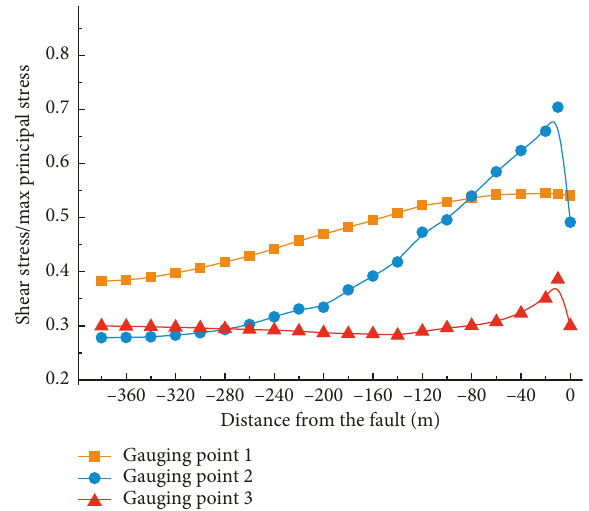
Figure 10: The ratio of shear stress to principal stress during advance of the working face.